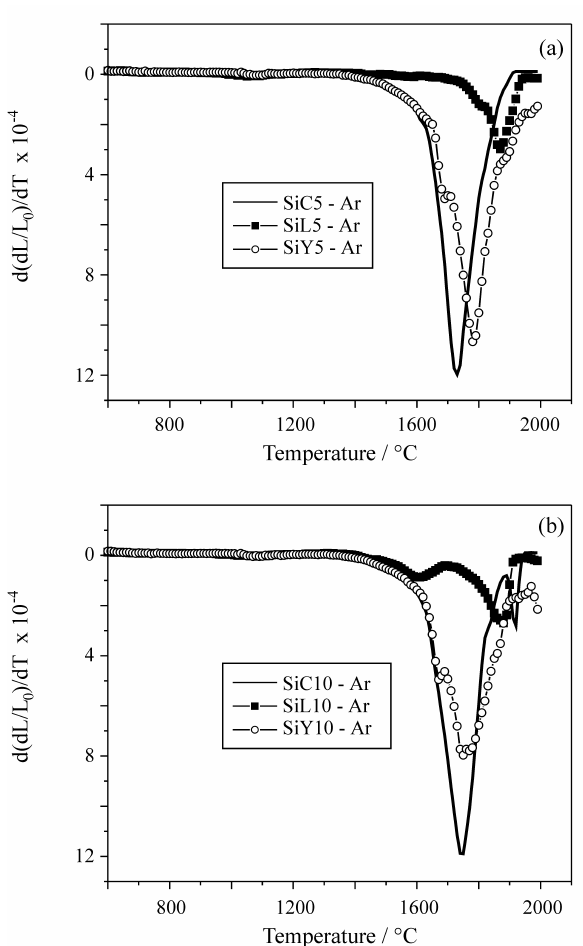
Figure 6. The results of dilatometric experiments: shrinkage rate vs. temperature while sintered in argon: a) 5wt% α -SiC; b) 10wt% α